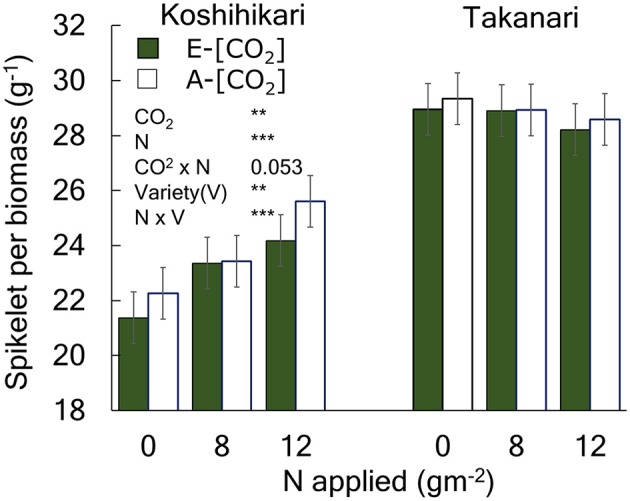
The effects of N and [CO2] on the spikelet number per unit aboveground biomass of Koshihikari and Takanari. The 3-year averages and a summary of ANOVA results with significant treatment and variety effects are shown in this figure. All data and the ANOVA results are provided in Table S2. *** and ** indicate significant differences at P = 0.001 and 0.01, respectively. The value indicates the probability between 0.05 and 0.1. Vertical bars are the standard errors of the residual of the ANOVA.